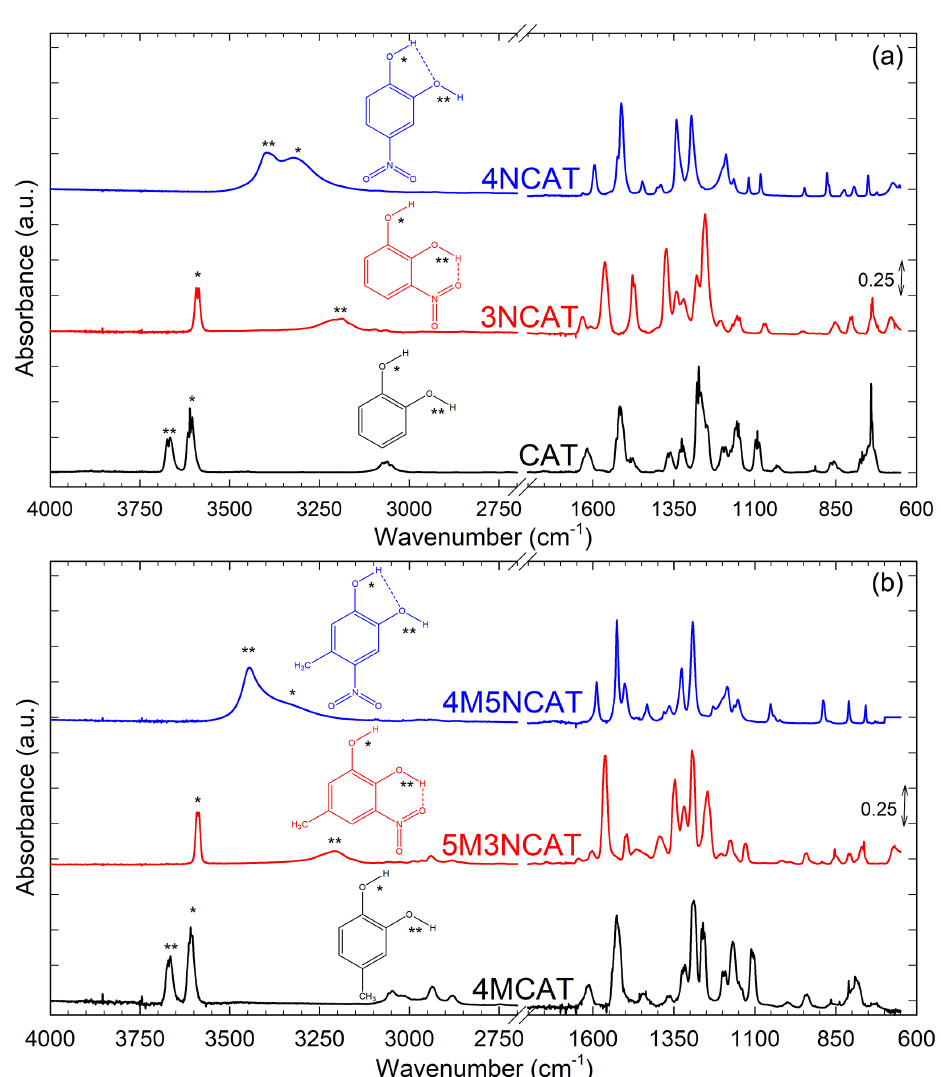
Figure 5. (a) Gas-phase IR spectra of catechol (CAT), 3NCAT, 4NCAT; (b) Gas-phase IR spectra of 4-methylcatechol (4MCAT), 5M3NCAT, and 4M5NCAT. Evidence for the intramolecular H-bond occurrence between the substituents marked with */**: catechol and 4MCAT – both free OH present in the spectra; 3NCAT and 5M3NCAT – only one free OH; 4NCAT and 4M5NCAT – both OH involved in the